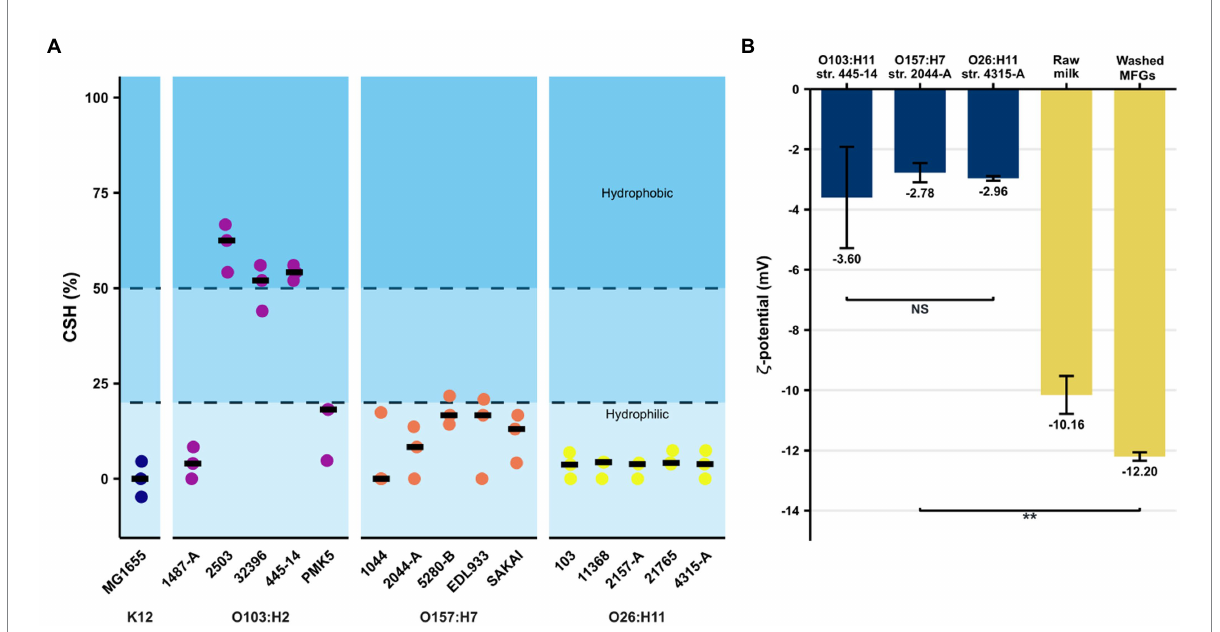
FIGURE 2 Evaluation of non-specific interactions between E. coli strains and bovine raw MFGs. (A) Cell surface hydrophobicity (in %) of the STEC strain collection evaluated by MATH test. A CSH ≤ 20% means a hydrophilic tendency while a value between 20 and 50% corresponds to moderately hydrophobic strains, and a result above 50% indicates a hydrophobic profile. Black bars represent the median of three independent experiments. (B) Measures of ζ -potential of MFGs in milk or dispersed in UFMP as well as the AEEC strains belonging to three key serotypes (O157:H7, O26:H11, and O103:H2). Bars correspond to the median and error bars represent the standard deviation. ** indicates significant differences (value of p <0.01), using the Wilcoxon signed-rank test. NS, not